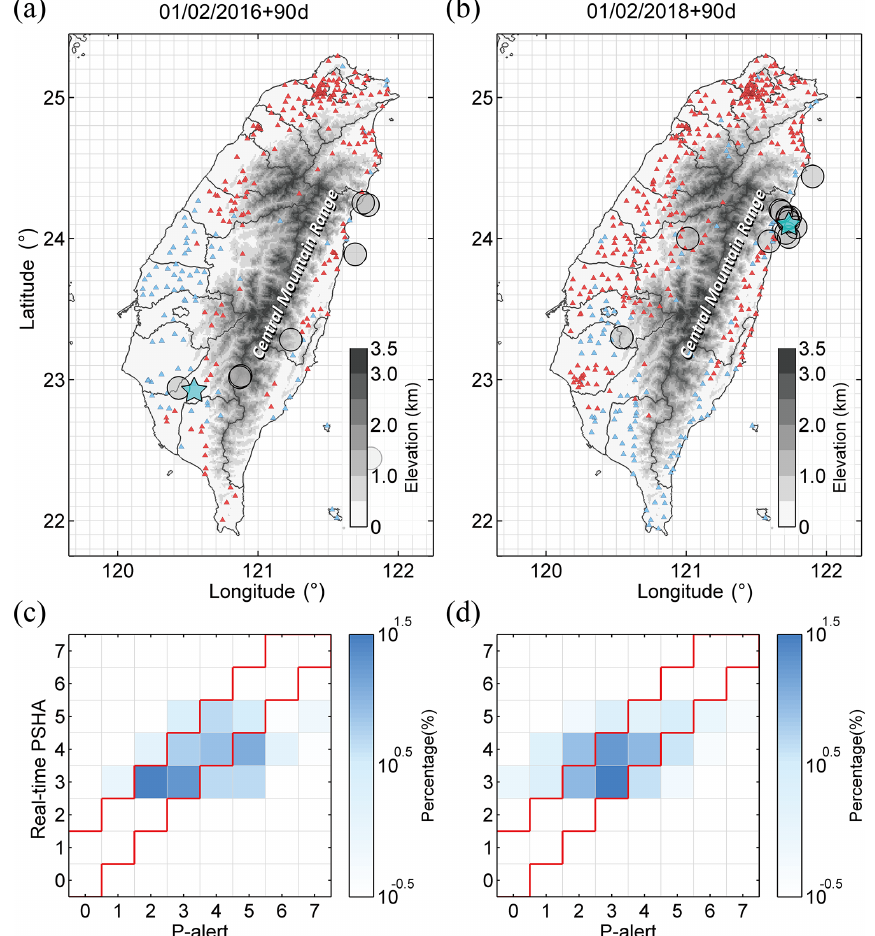
Figure 5. Panels (a) and (b) are the P-alert station distributions indicating “hit” and “not hit”. The red and blue triangles represent “hit” and “not hit”, respectively. Panels (c) and (d) are the distributions of the hit percentage for the 2016 Meinong and 2018 Hualien earthquakes, respectively. The red line area represents the acceptable prediction